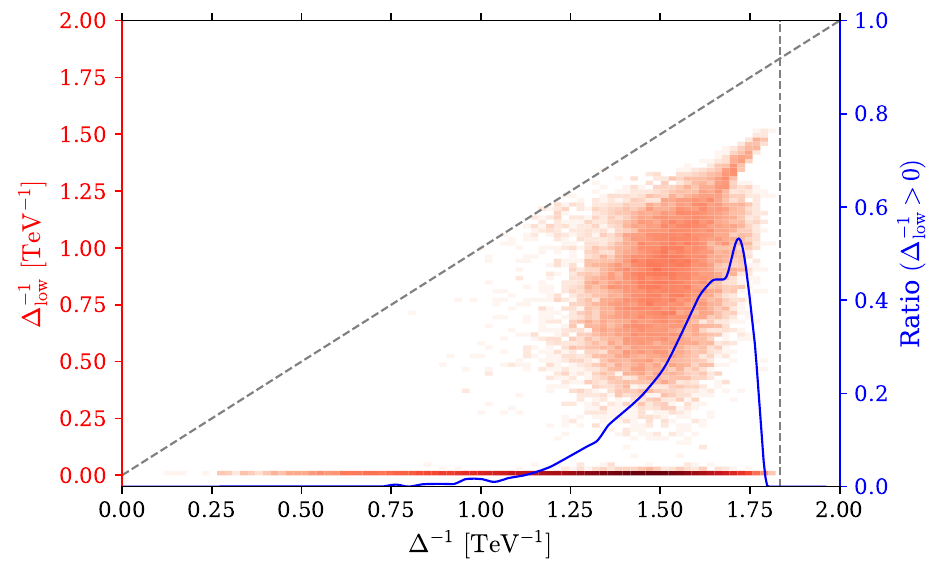
Figure 7 . Distribution of positivity violation in terms of (∆ − 1 , ∆ − 1 ) at the 95 % confidence level low for the HL-LHC collider (red points, left vertical axis), for a sample of 10 5 points in the Wilson coefficient space. We set Λ = 1 TeV in this analysis. We also plot the ratio of points whose ∆ − 1 low is nonzero for a given ∆ − 1 (blue solid line, right vertical axis). ∆ − 1 does not exceed the horizontal axis value of the vertical grey dashed line that corresponds to the radius of the 7-dimensional